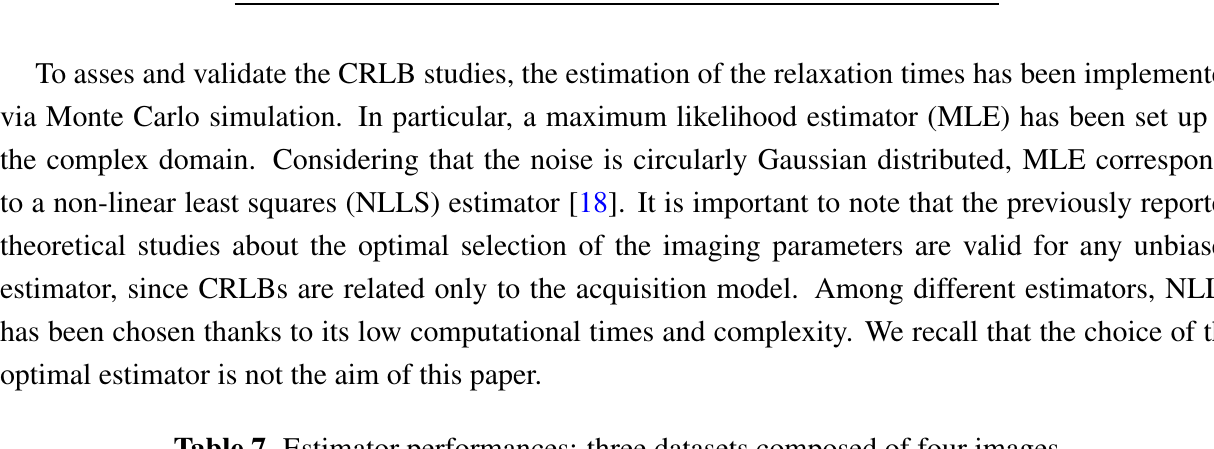
Table 7. Estimator performances: three datasets composed of four